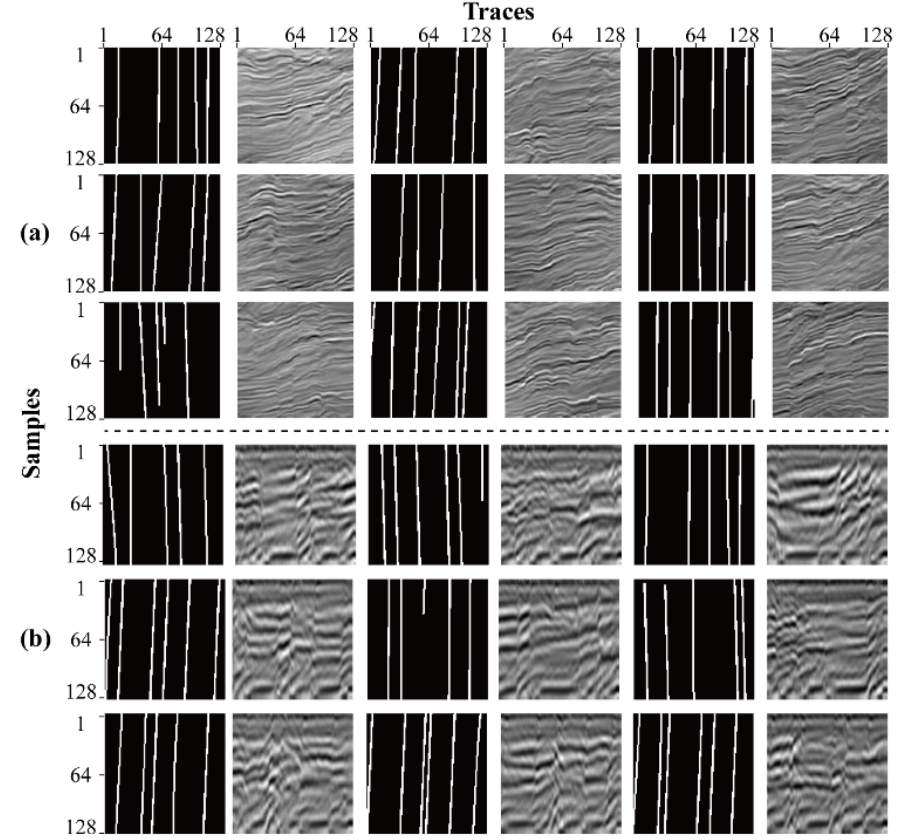
Figure 4. Input labels and output Kerry (a) and Data1 (b) samples (left, binary labels; right, the corresponding fault data).